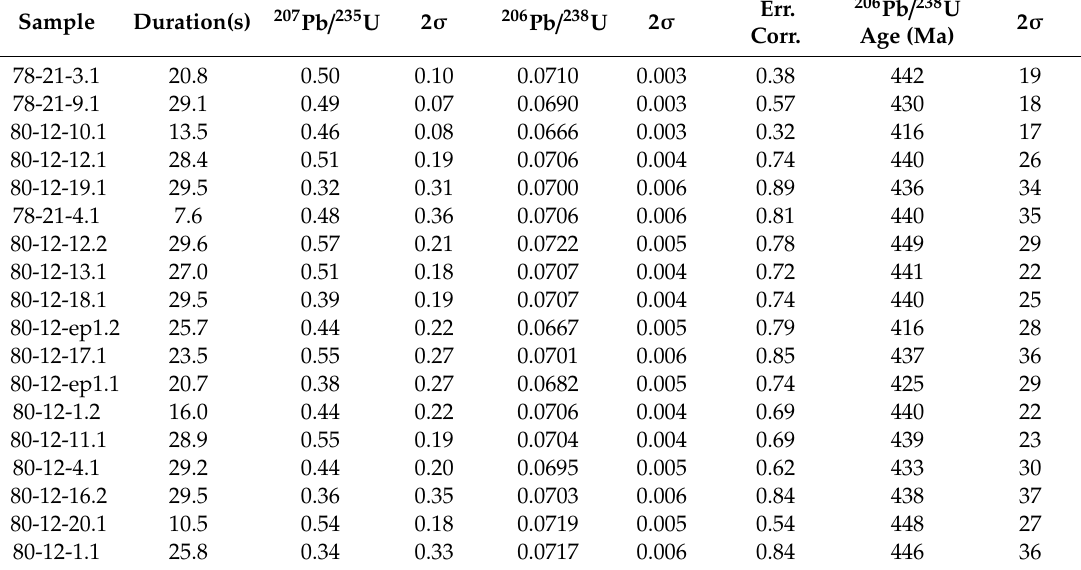
Figure 15. Oldest population of five 204 Pb corrected titanite analyses from a lamprophyre dyke plotted on the concordia diagram. The date listed above is a 204 Pb corrected concordant 206 Pb- 238 U age (data shown in Table 2). Data point error ellipses are reported at 2 σ . Table 3. U-Pb titanite geochronological data from the intermediate population in the lamprophyre dyke (samples 78-21 and